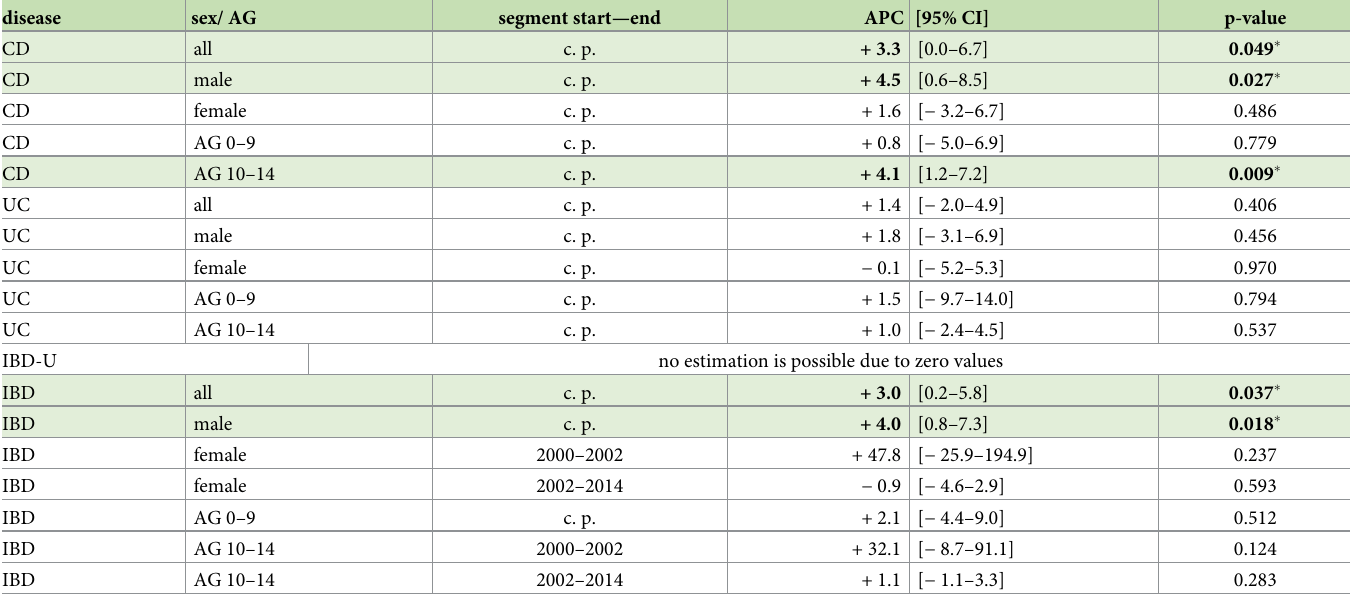
Table 3. Results of the incidence trend analysis of inflammatory bowel disease (IBD), Crohn’s disease (CD), ulcerative colitis (UC) and unclassified IBD (IBD-U) by sex and age groups (AG) using joinpoint regression and annual percent change (APC) over the period 2000–2014. disease